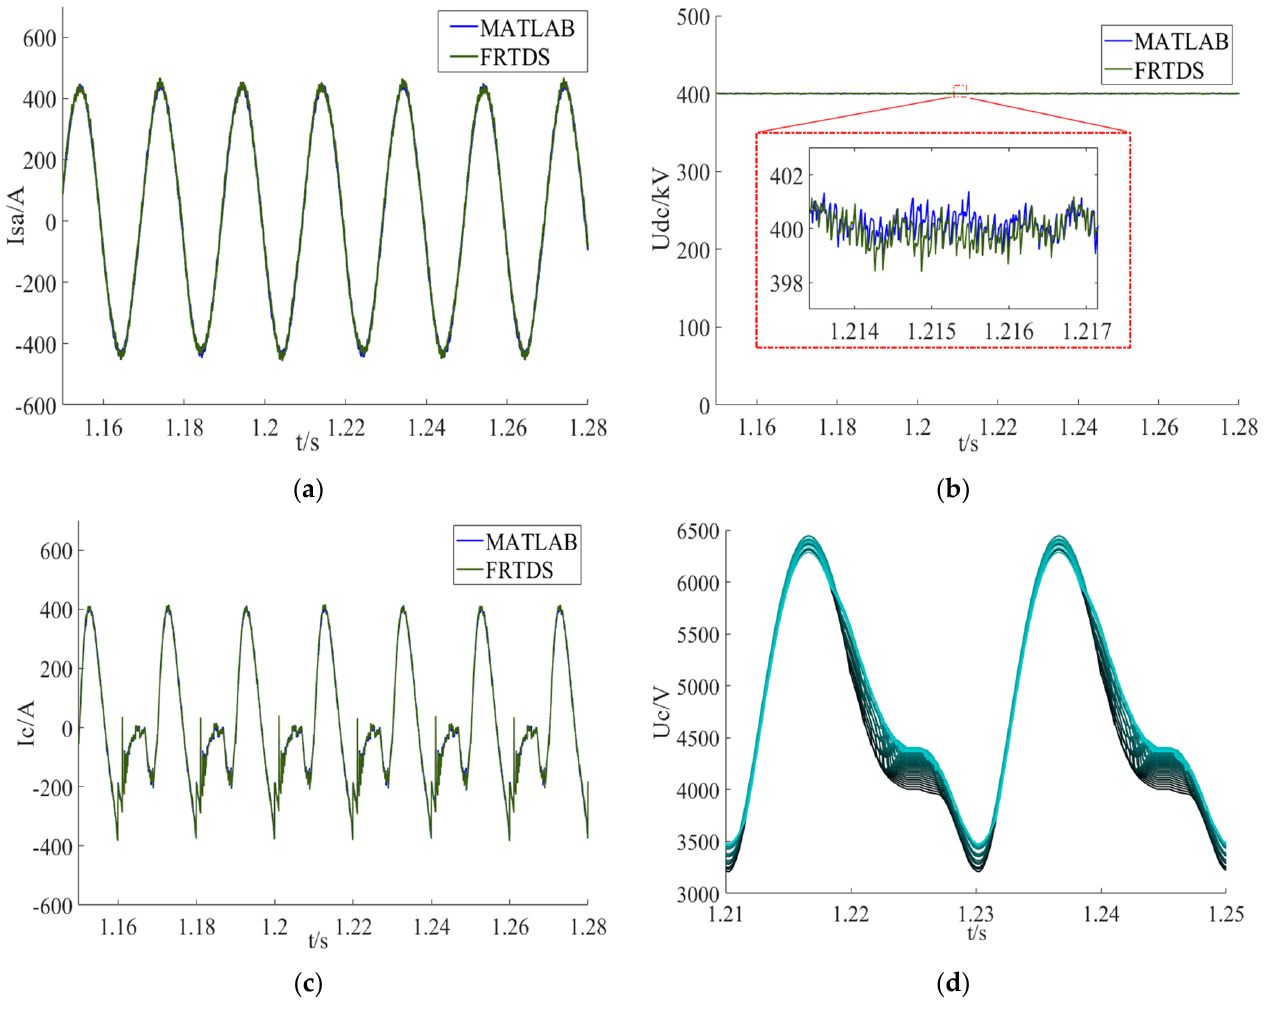
Figure 14. Steady ‐ state operation waveform of the MMC simulation system: ( a ) A ‐ phase AC current waveform of inverter side; ( b ) DC ‐ side voltage waveform; ( c ) waveform of the capacitor current of the upper bridge arm in phase A on the rectifier side; ( d ) capacitor voltage of the upper bridge arm in phase A on the rectifier side.